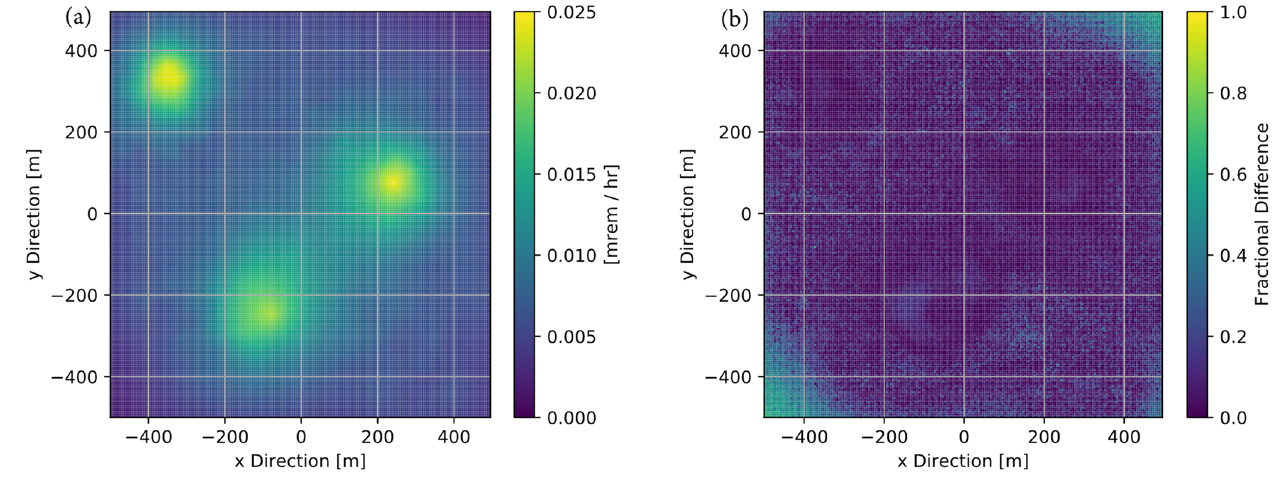
Figure 3. Five-sensor survey results showing ( a ) the predicted distribution for E = 0.90 and ( b ) the grid-by-grid fractional difference to the true distribution shown in Figure 1.